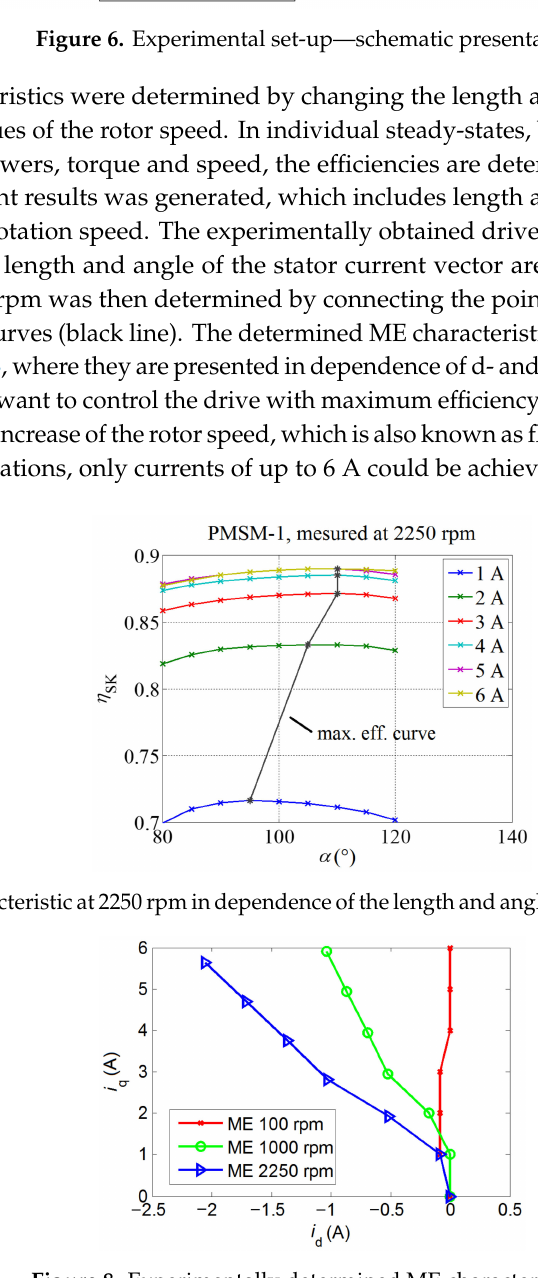
Figure 8. Experimentally determined ME